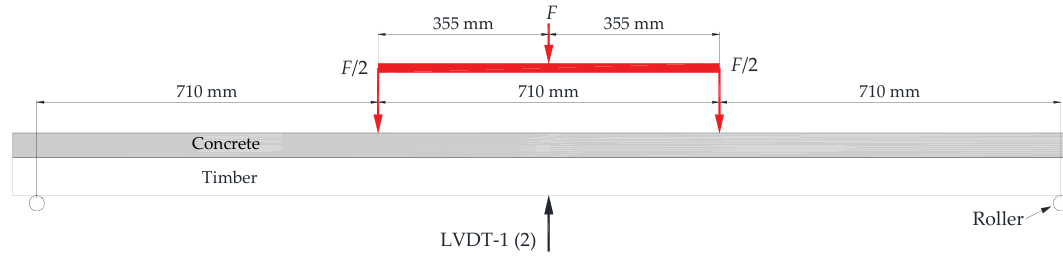
Figure 2. Setup of 4-point bending test.